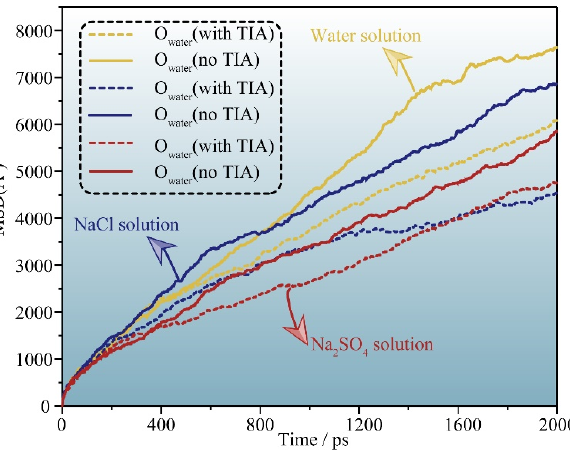
Figure 5. Mean square displacement function of oxygen atoms in water molecules in different solu ‐ tions.